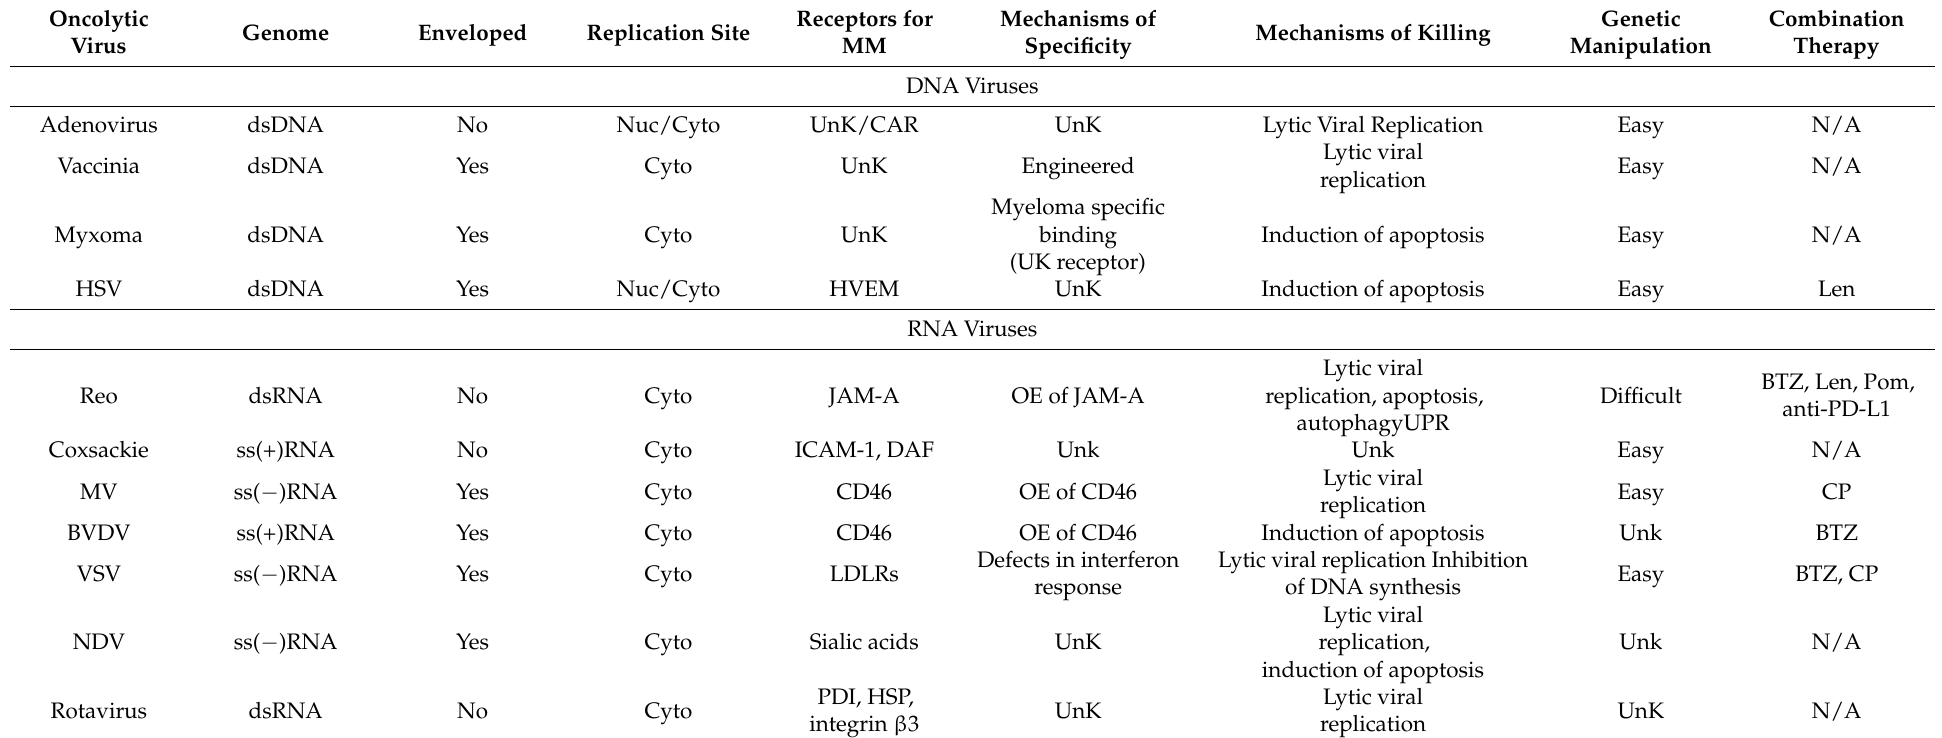
Table 1. Preclinical development of oncolytic viruses for multiple